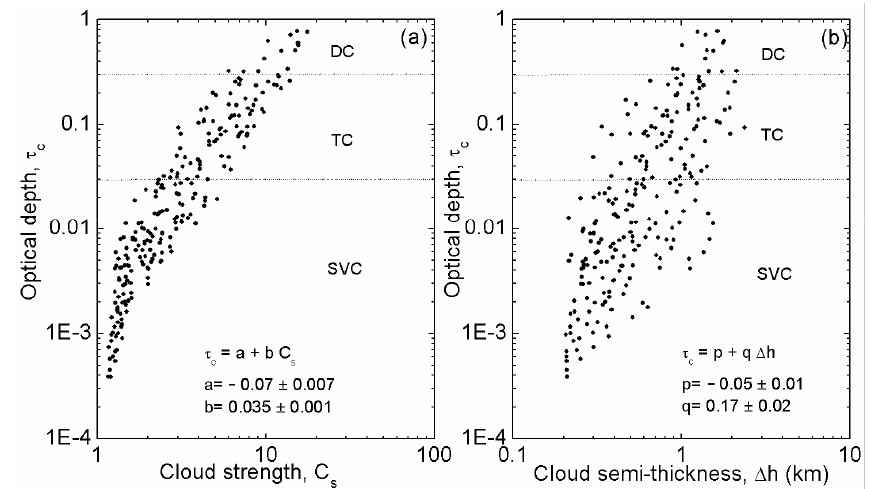
Fig. 8. Scatter plots showing the dependence of cloud optical depth ( τ c ) on cloud strength ( C s ) and cloud semi-thickness ( 1h ).